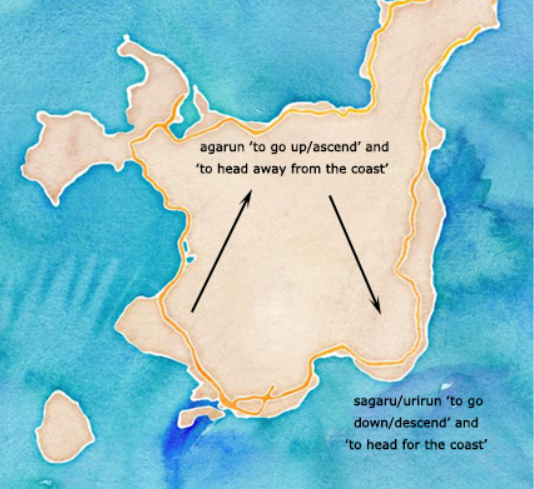
Figure 3. Landmark (intrinsic/inherent) reference system in Ishigaki. Map tiles by Staen Design, CC BY 3.0 © OpenStreetMap.